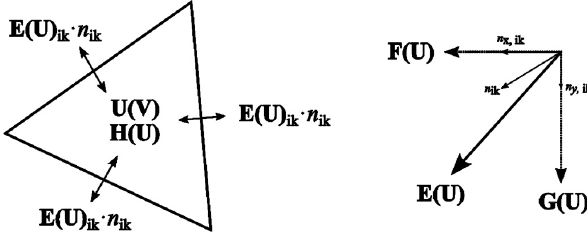
Fig. 1. Scheme of variables involved in the numerical